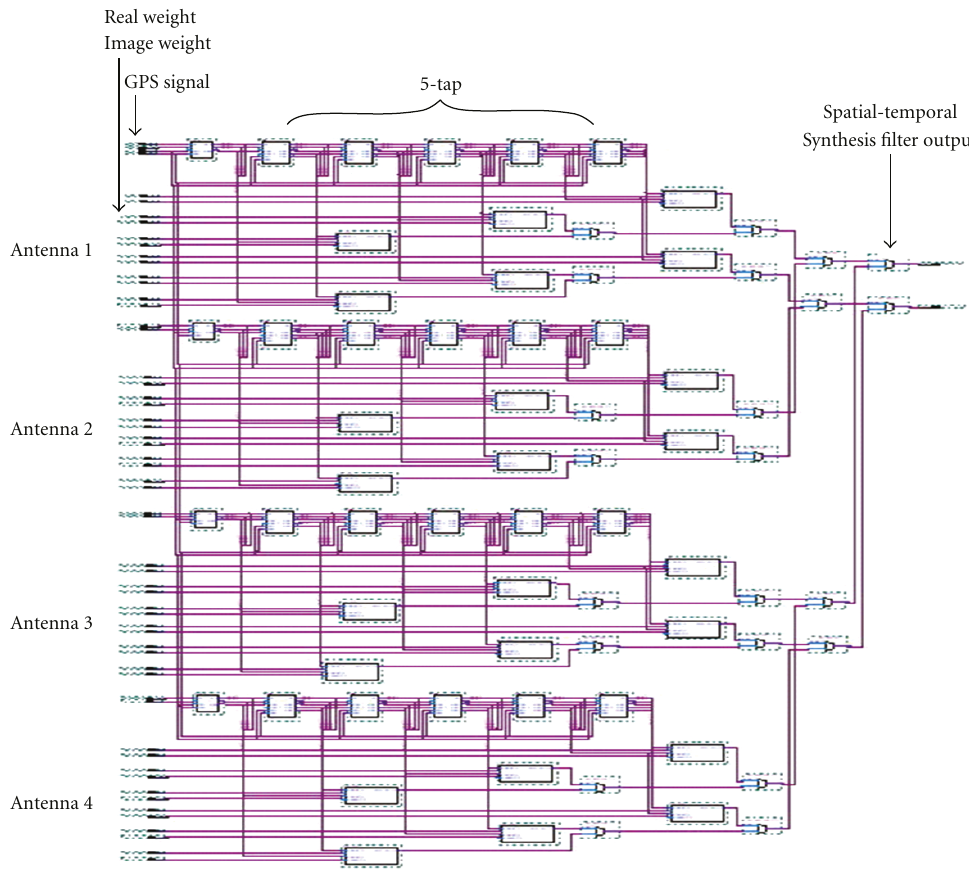
Figure 5: Self-tuning synthesis filter structure.